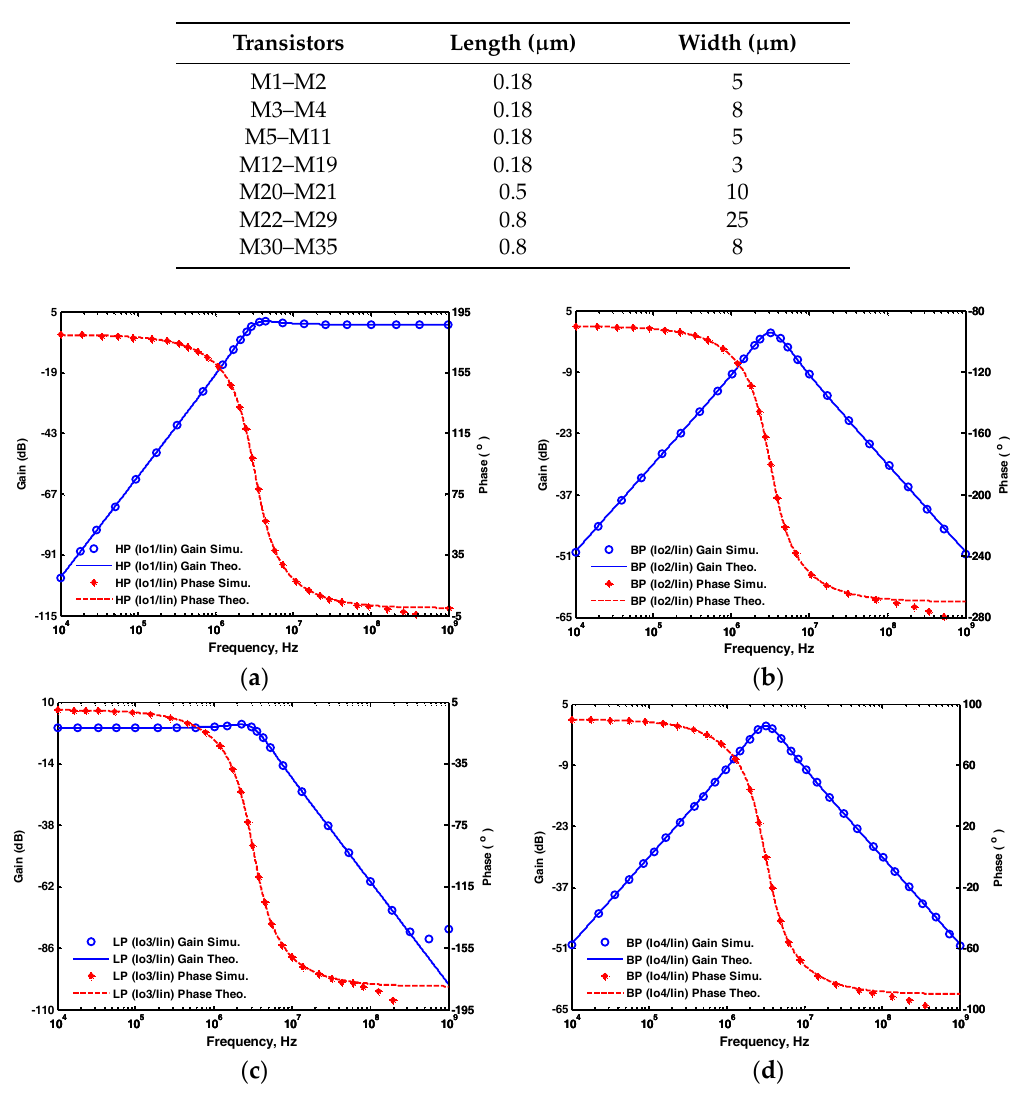
Figure 5. The CM-simulated frequency responses of Figure 2 ( a ) highpass filter; ( b ) bandpass filter; ( c) lowpass filter; and ( d ) bandpass filter.